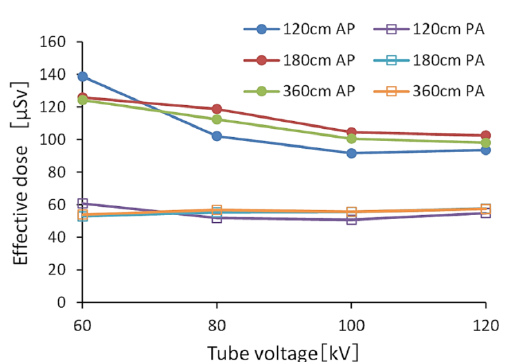
Figure 4. The effective dose calculated by the PC-based Monte Carlo program for calculating patient doses in medical X-ray examinations (without a grid). (AP: anteroposterior, PA: posteroanterior).